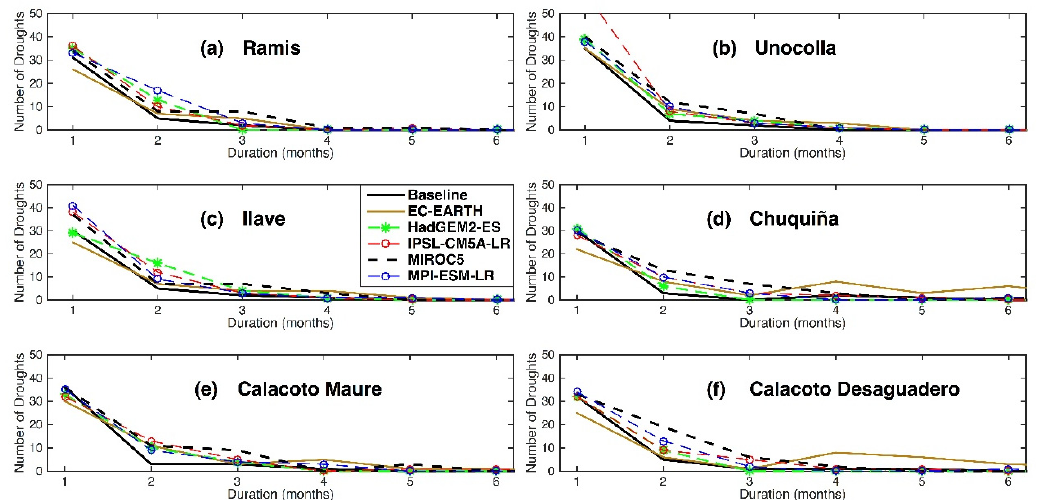
Figure 10. Frequency of agricultural droughts according to their duration. Results for baseline and futures scenarios defined by five selected GCM are shown for six sub-basins controlled at the following stations: ( a ) Ramis (1), ( b ) Unocolla (2), ( c ) Ilave (3), in Peru, and ( d ) Chuquiña (7), ( e ) Calacoto Maure (6), ( f ) Calacoto Desaguadero (5), in Bolivia. Numbers in parentheses indicate the location of control points in Figure 1b.